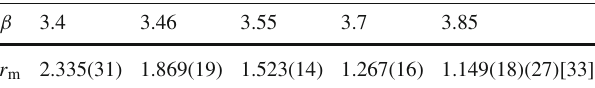
Table 5 Values for r m at the couplings used in CLS simulations, obtained from the interpolation formula (5.5). As mentioned in the text, an additional systematic error was added to the β = 3 . 85 result. The errors are displayed in this way: (σ stat )(σ syst ) [ σ total